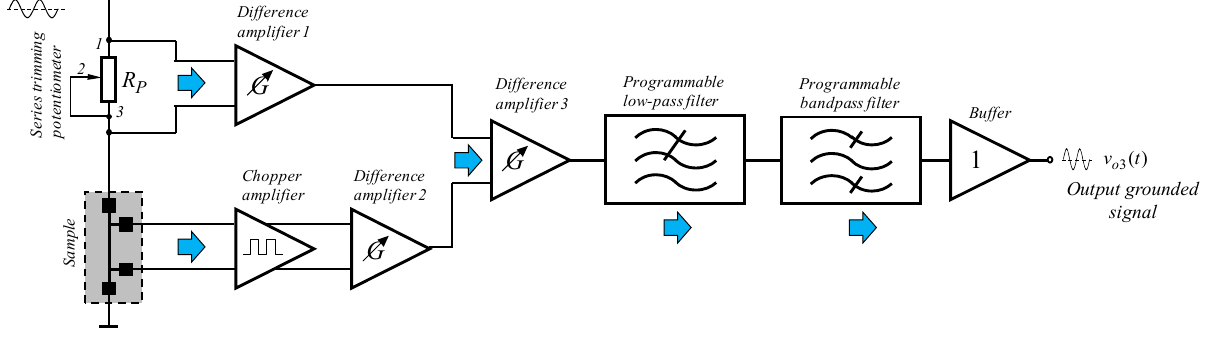
Figure 2. Block diagram of the programmable analog circuit for measuring the amplitude of a third harmonic, which is generated in the study of thin-film solar cells.